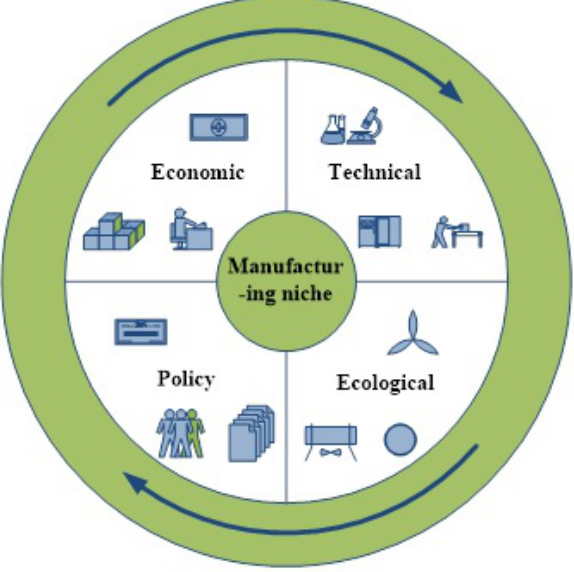
Fig. 1 Factors of manufacturing